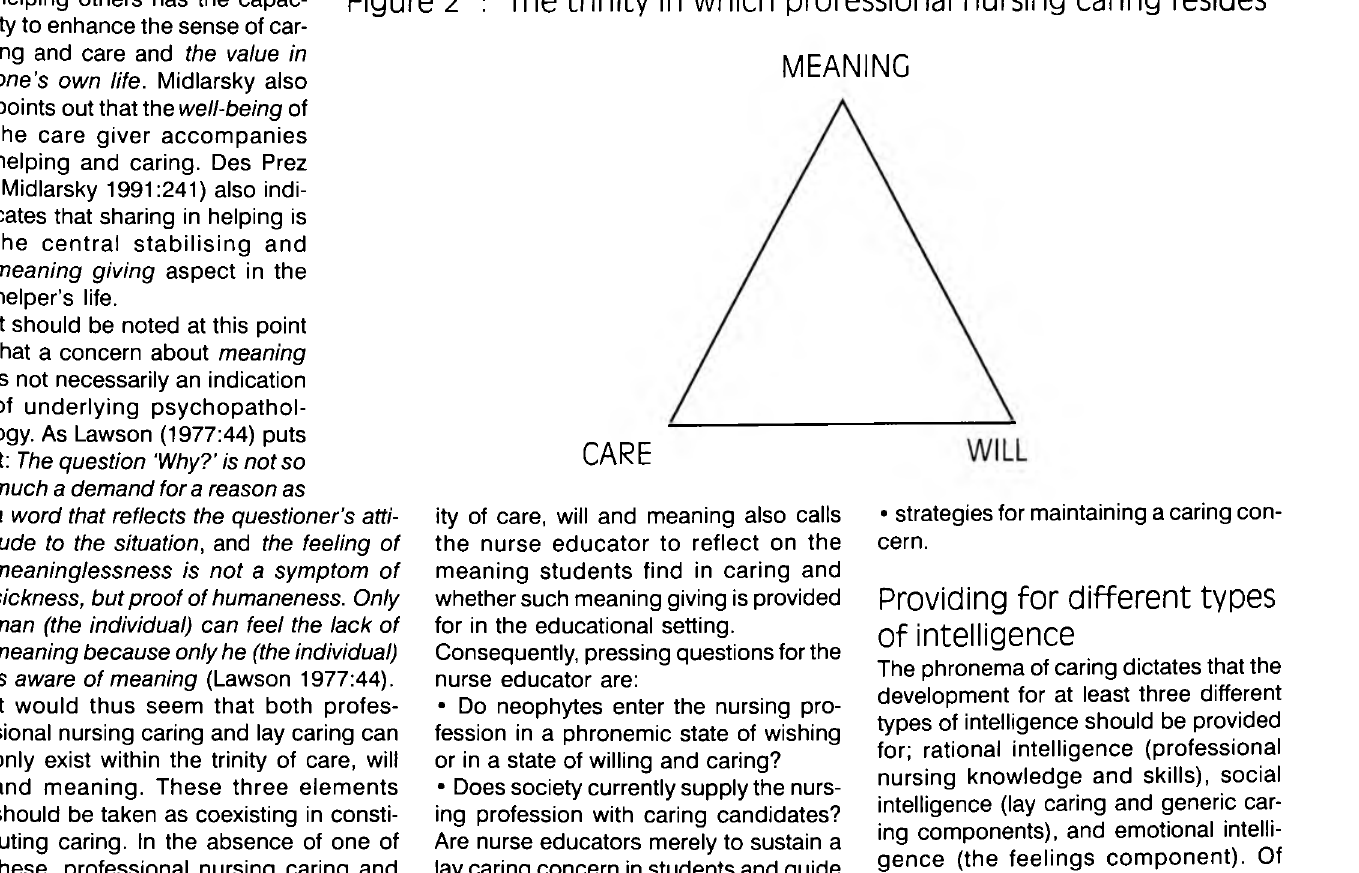
Figure 2 : The trinity in which professional nursing caring resides